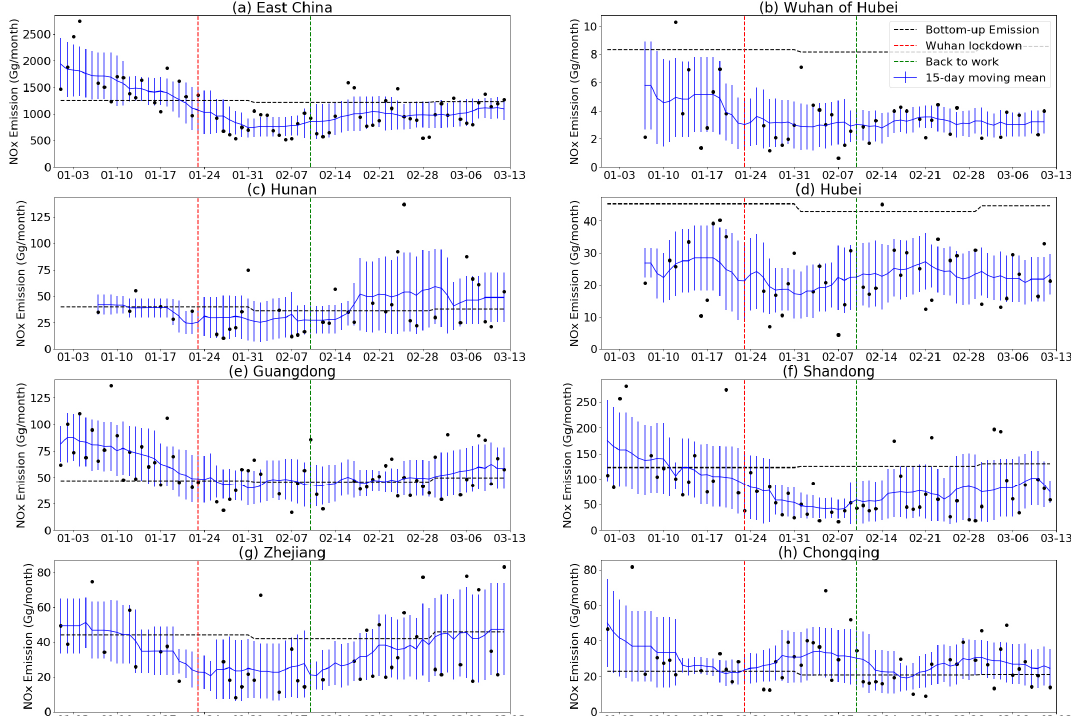
Figure 4. ( a–h ) Daily top-down emissions (black dots) in different regions. The horizontal black dash lines represent bottom-up emissions (MEIC) to show the a priori knowledge of the month-to-month variation of NOx emissions. The blue solid line represents 15-day center moving averages of daily top-down emissions, and the error bars represent corresponding standard deviations of the data in the 15-day window. Vertical red and green dashed lines represent the dates of Wuhan lockdown and official back-to-work day.